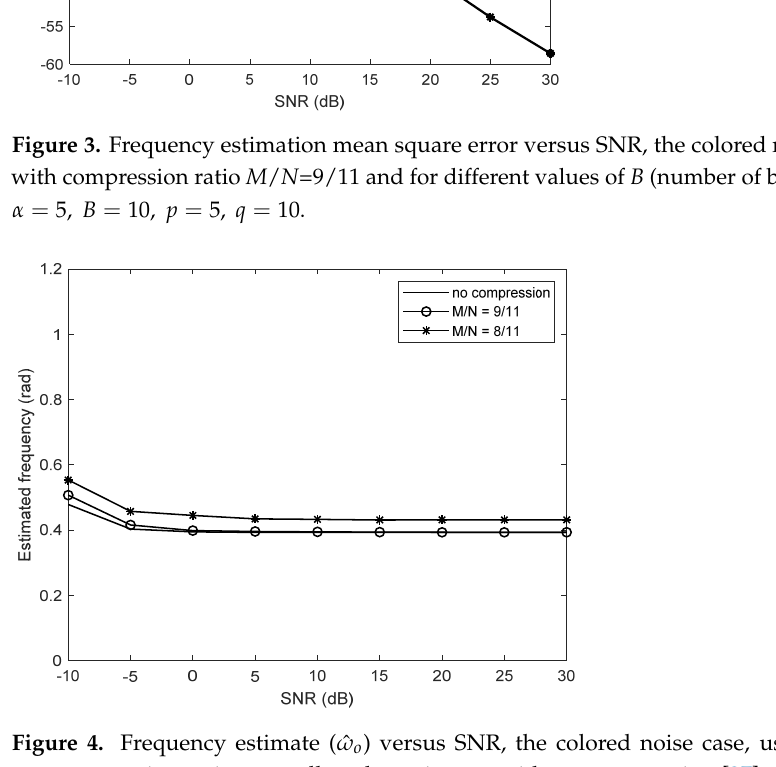
= 0.393 rad, 𝛼 = = 0.393 rad, (cid:2876) 8